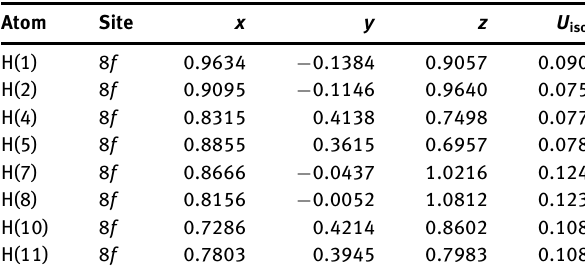
Thecrystalstructureisshowninthefigure,Tables1–3contain details of the measurement method and a list of the atoms including atomic coordinates and displacement parameters.